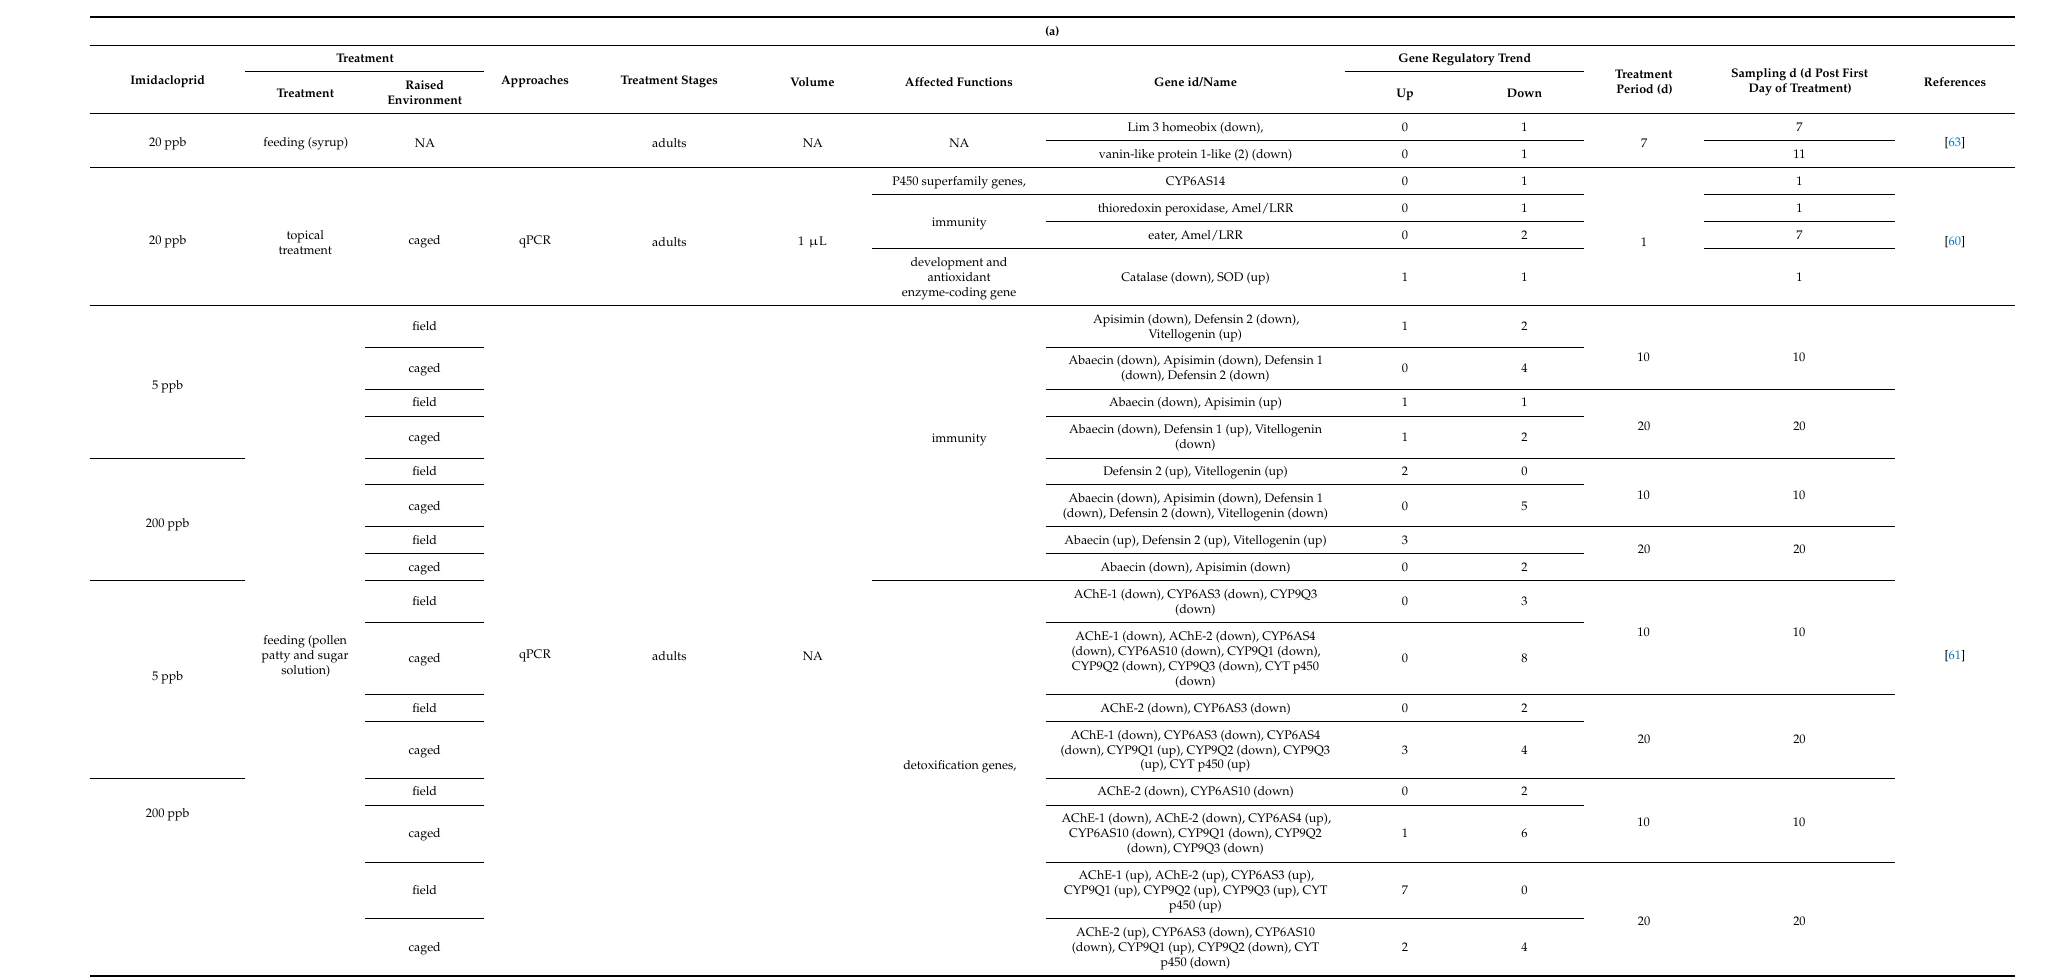
Table 2. ( a ). Differentially expressed genes, of the honey bee after imidacloprid treatment during the adult stage. ( b ) Differentially expressed genes, of the queen bee after imidacloprid treatment during the adult stage. ( c ) Differentially expressed genes, of honey bees after imidacloprid treatment during the larval